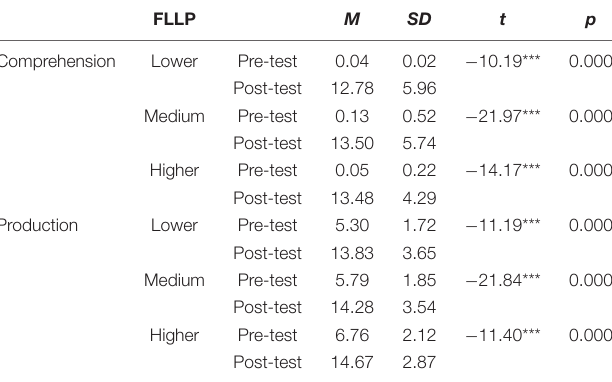
TABLE 3 | Pre–post TS comprehension and production of student translators with different